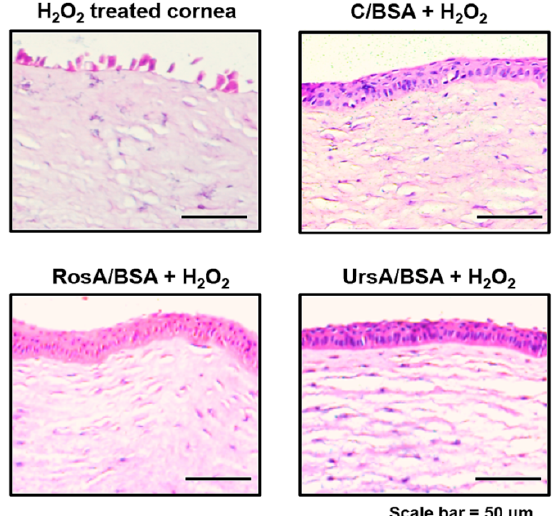
Figure 10. Histological examinations of rabbit cornea tissues after drug treatment (C / BSA, RosA / BSA, or UrsA / BSA formulation of 50 µ M) and then H 2 O 2 solution treatment. The cornea tissues were incubated with drug formulations for 18 h and then with 30 µ g / mL of H 2 O 2 for 4 h. Tissue sections were subjected to H&E staining and examined with a brightfield microscope (20 ×